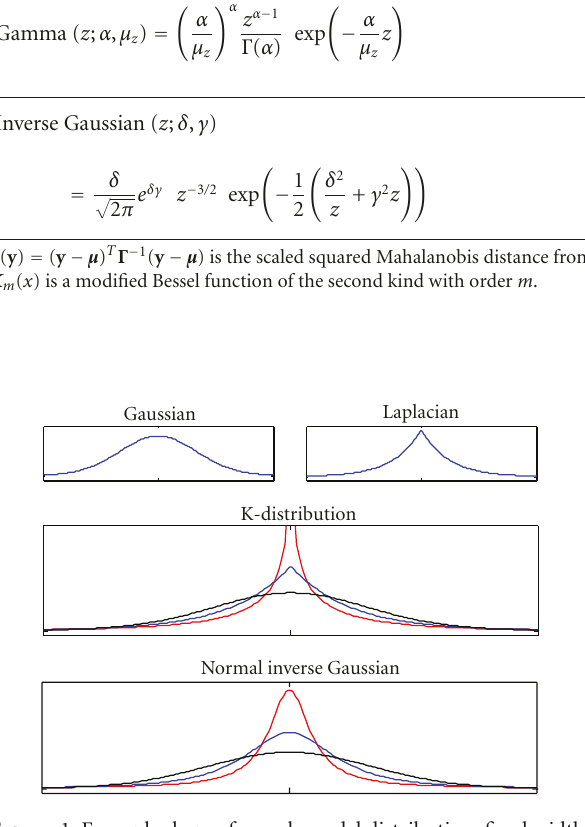
Figure 1: Example shapes for each model distribution, fixed width. The two parameter models, the K-distribution and the normal inverse Gaussian, can vary in